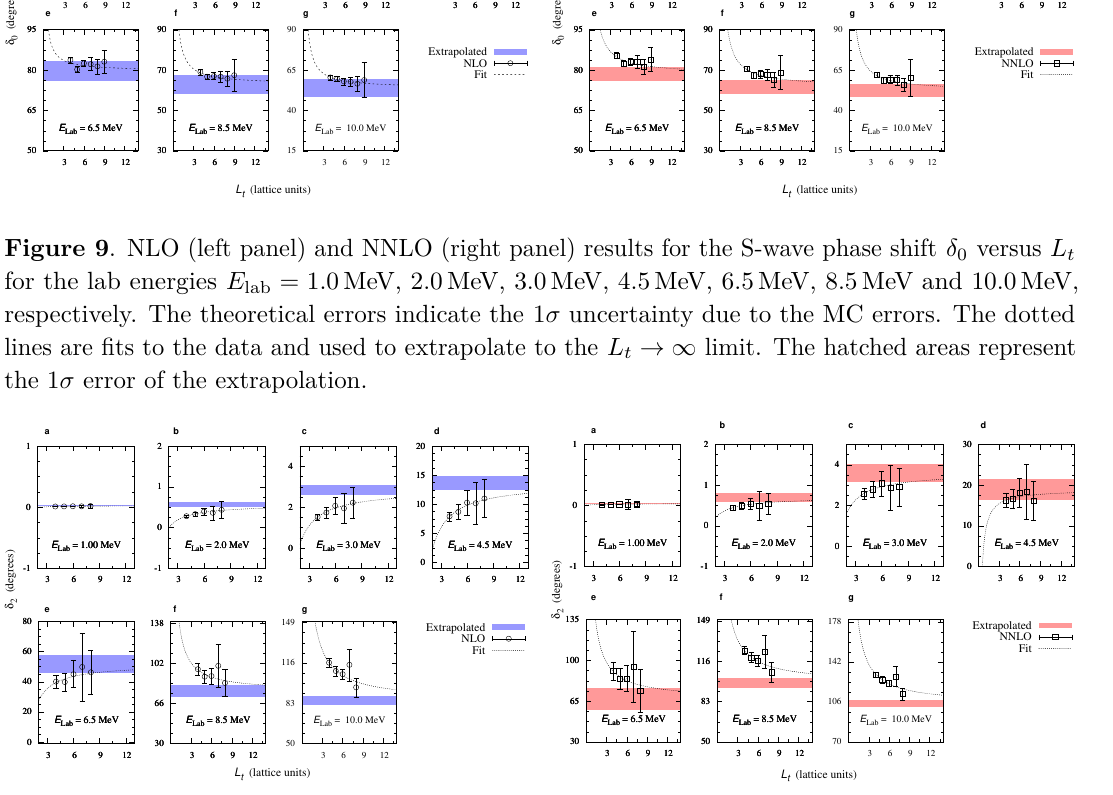
Figure 10 . NLO (left panel) and NNLO (right panel) results for the D-wave phase shift δ 2 versus L t for the lab energies E lab = 1 . 0 MeV, 2 . 0 MeV, 3 . 0 MeV, 4 . 5 MeV, 6 . 5 MeV, 8 . 5 MeV and 10 . 0 MeV, respectively. The theoretical errors indicate the 1 σ uncertainty due to the MC errors. The dotted lines are fits to the data and used to extrapolate to the L limit. The hatched areas represent t → ∞ the 1 σ error of the